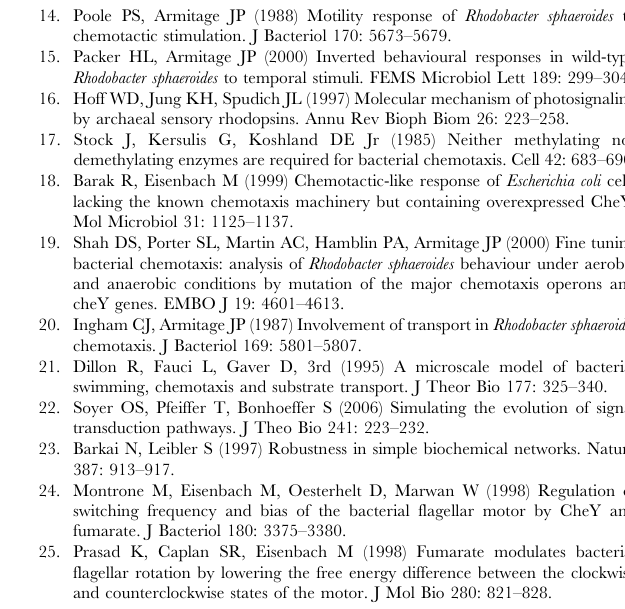
flagellar rotation by lowering the free energy difference between the clockwise and counterclockwise states of the motor. J Mol Bio 280: